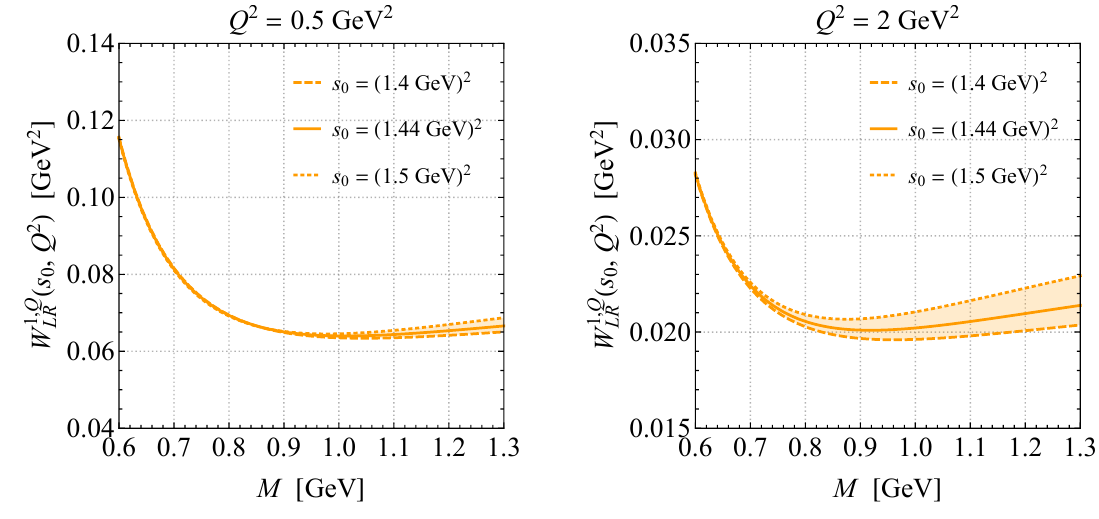
Figure 3 . As figure 2 but for the form factor W 1 ,Q